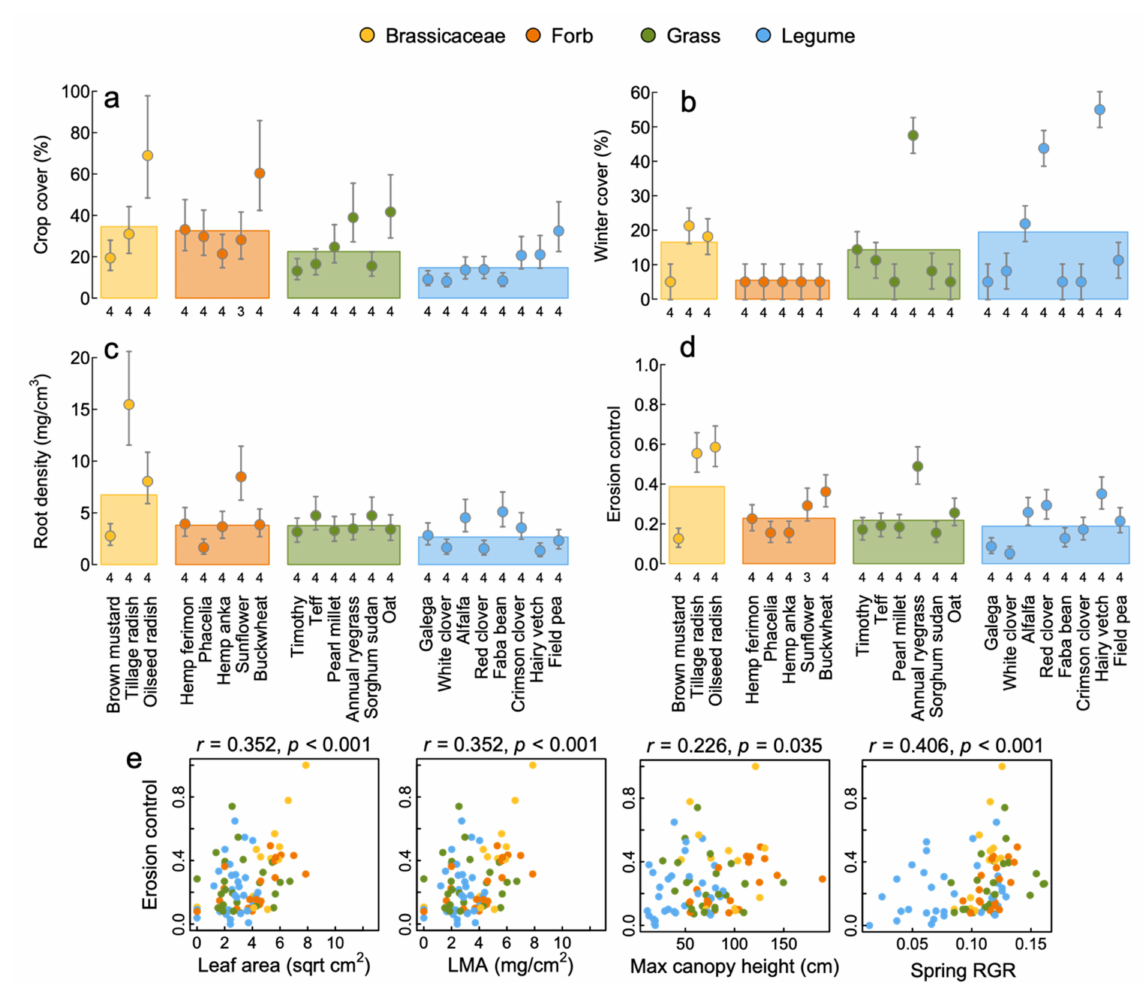
Figure 4. Erosion control. The average ground cover by crops ( a ), ground cover during the winter ( b ) and rooting density ( c ) and their scaled average used as the ecosystem service erosion control ( d ) are shown. Points show means, and error bars are model estimates of standard errors for comparison among means of the crops. The colored bars show overall means for each plant functional group (indicated by the different colors). Significant correlation (Spearman) between weed suppression and plant functional traits are shown in ( e ). Numbers below each mean are the number of replicates used. Statistics are provided in Table 2. Note, LMA = leaf mass per area and RGR = relative growth